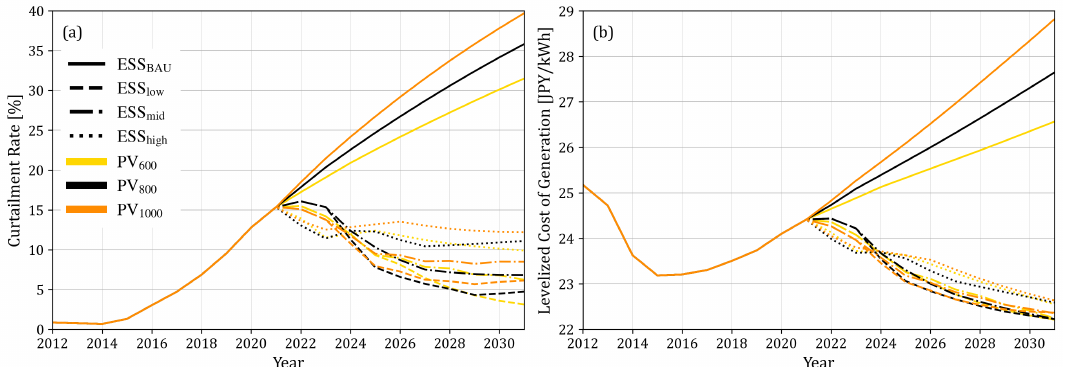
Figure 15. ( a ) Curtailment rate of solar and ( b ) Levelized Cost of Generation of the business as usual (BAU; no change in ESS capacity) and the optimal ESS scenario.